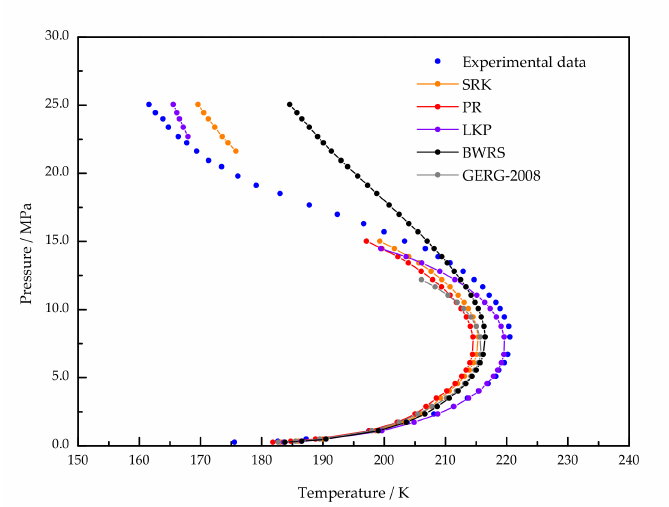
Figure 3. Experimental and calculation results of dew points for Sample 2.